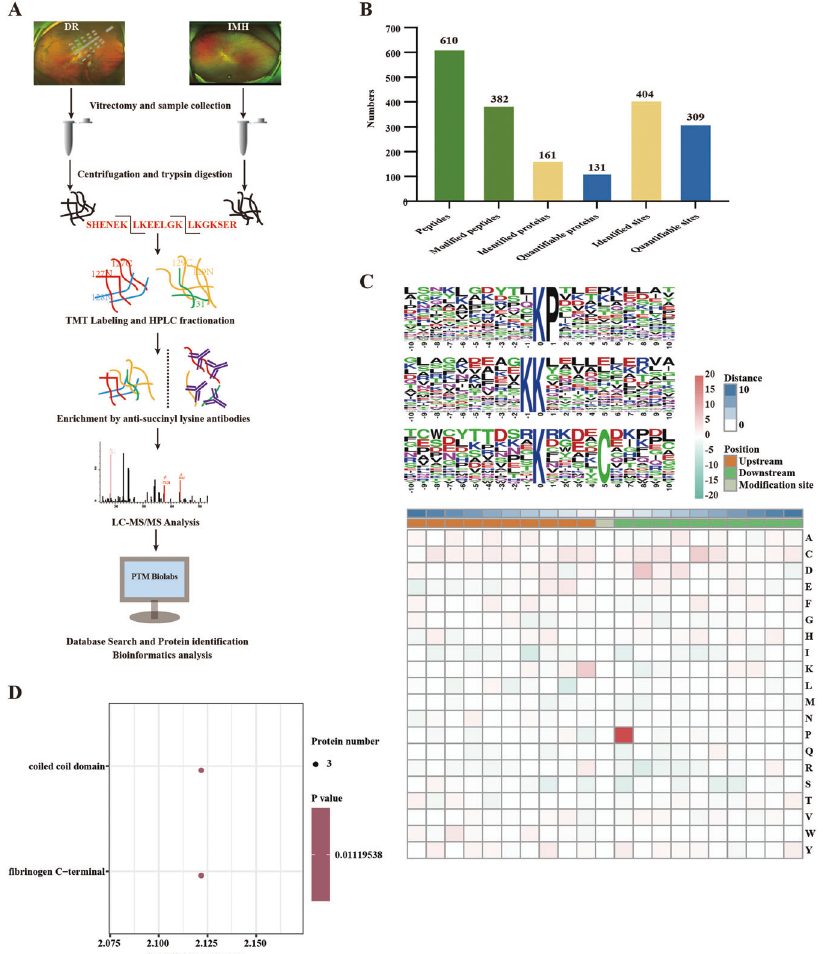
Fig. 1 Lysine succinylome analysis of vitreous humor from DR and IMH patients. A Integrated strategy for the identi fi cation and quantitative pro fi ling of the succinylome between the DR and IMH vitreous humor. B Basic statistical fi gure of MS results. C The motif enrichment heatmap of upstream and downstream amino acids of all identi fi ed modi fi cation sites. Red indicates that this amino acid is signi fi cantly enriched near the modi fi cation site, and green indicates that this amino acid is signi fi cantly reduced near the modi fi cation site. D Protein domain enrichment bubble plot of proteins corresponding to all identi fi ed modi fi cation proteins. DR diabetic retinopathy, IMH idiopathic macular hole, MS mass